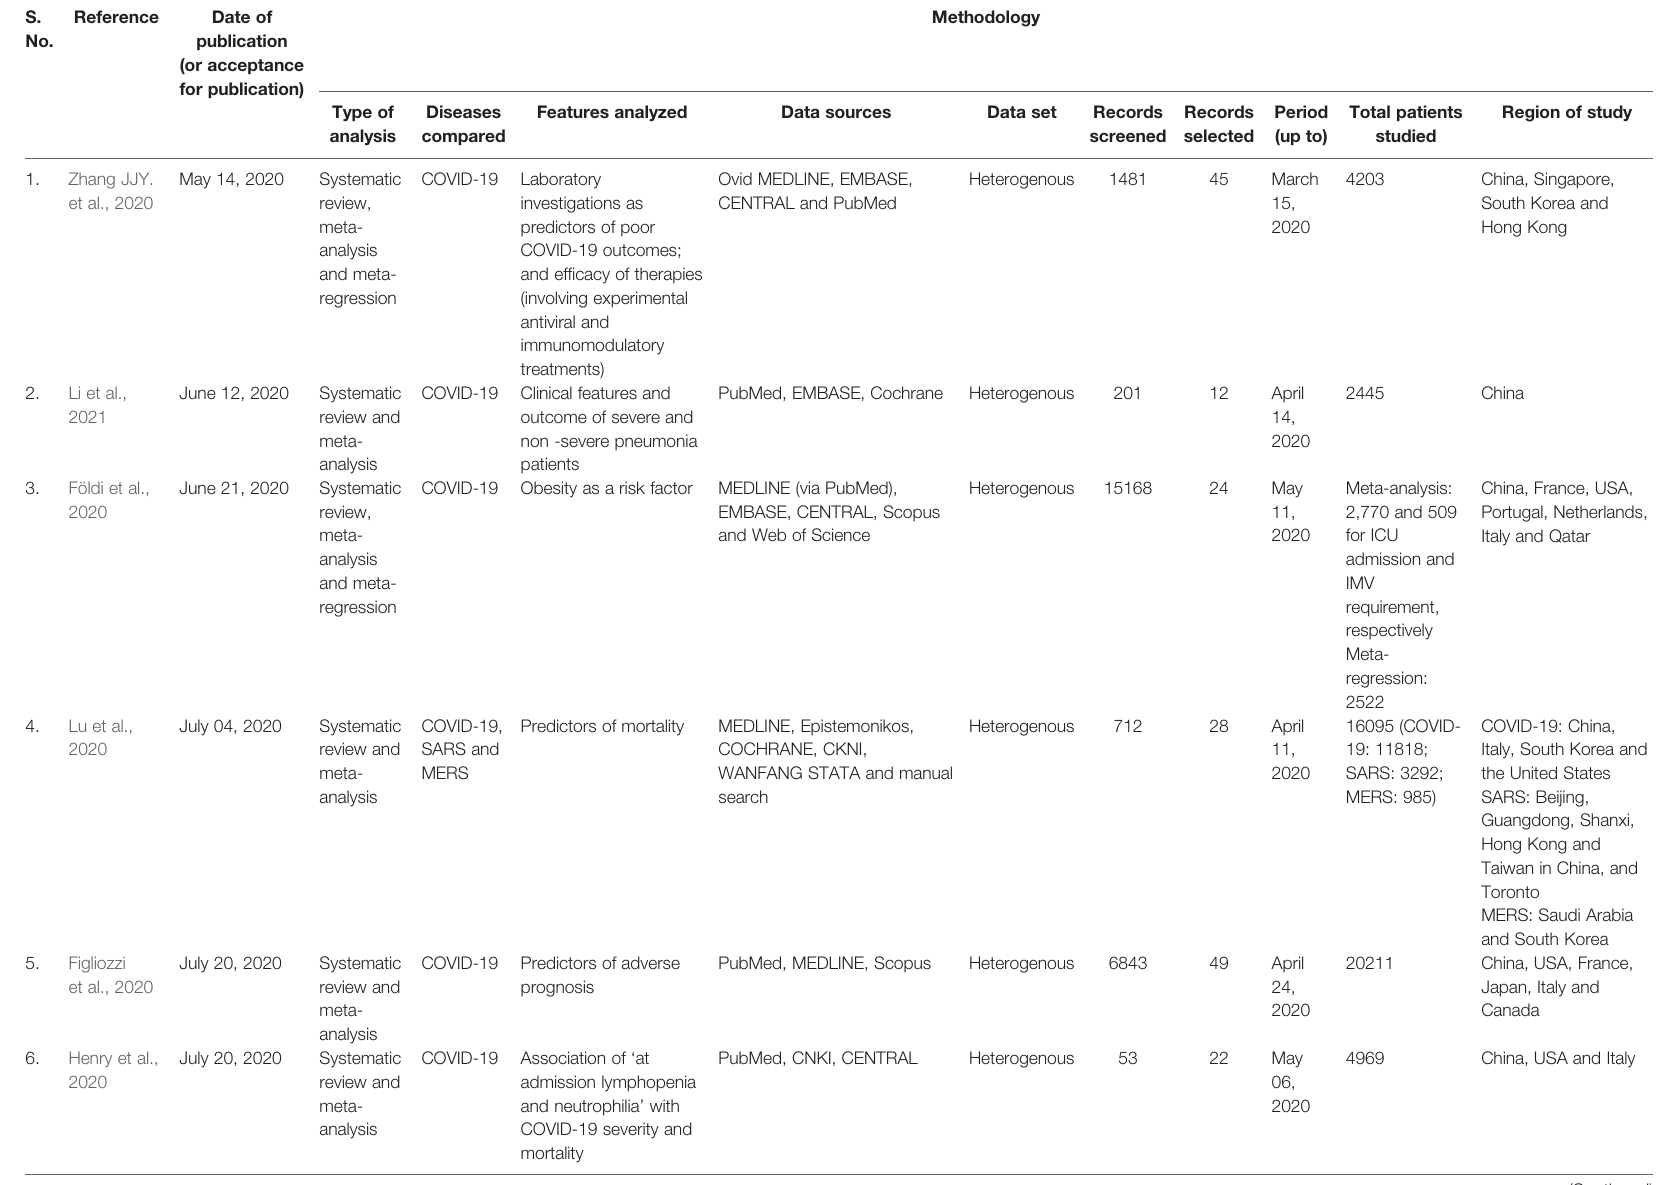
TABLE 1A | Overview of the methodology of the analyzed systematic reviews and meta-analysis in relation to severity, adverse prognosis and mortality of